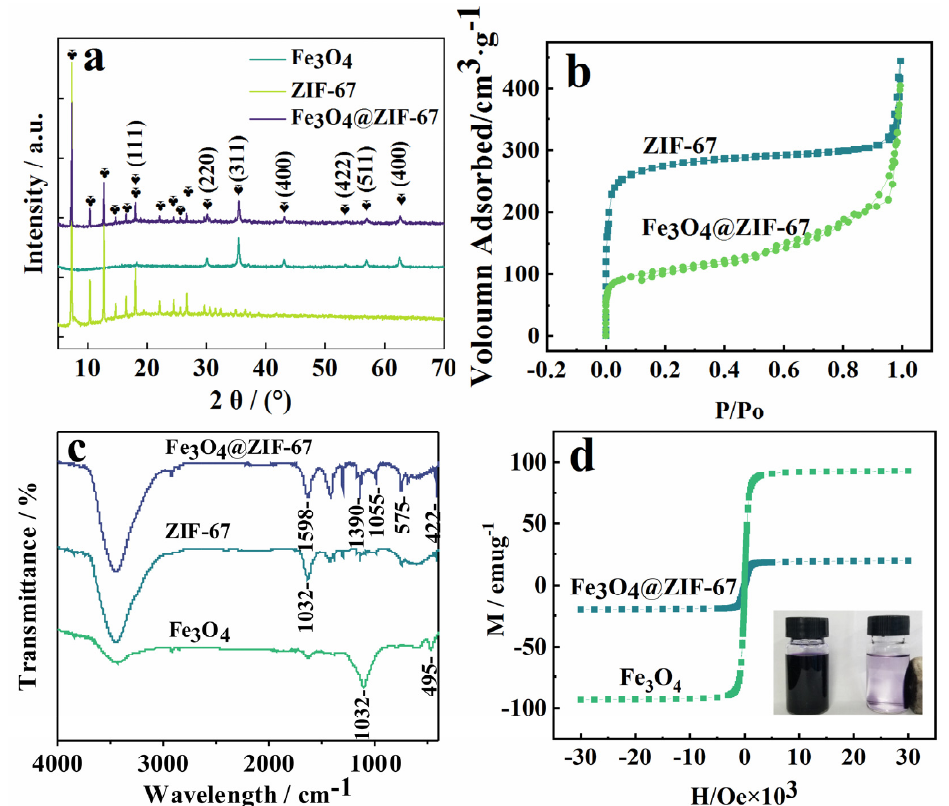
Figure 2. ( a ) XRD patterns of Fe 3 O 4 @ZIF − 67, ZIF − 67, and Fe 3 O 4 . ( b ) Nitrogen adsorption– desorp- tion isotherms of ZIF − 67 and Fe 3 O 4 @ZIF − 67 at 77K. ( c ) FT-IR spectra of Fe 3 O 4 @ZIF − 67, ZIF − 67, and Fe 3 O 4 . ( d ) Hysteresis loops of Fe 3 O 4 and Fe 3 O 4 @ZIF − 67; inset, photographs of Fe 3 O 4 @ZIF − 67 before and after magnetic separation with an external magnet.